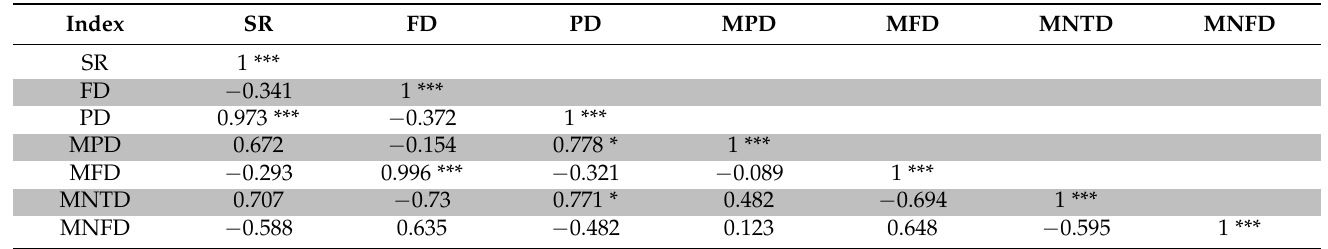
Table 1. Bivariate Pearson correlation coefficients between multiple diversity dimensions of small mammals in Qingliang Mountain.